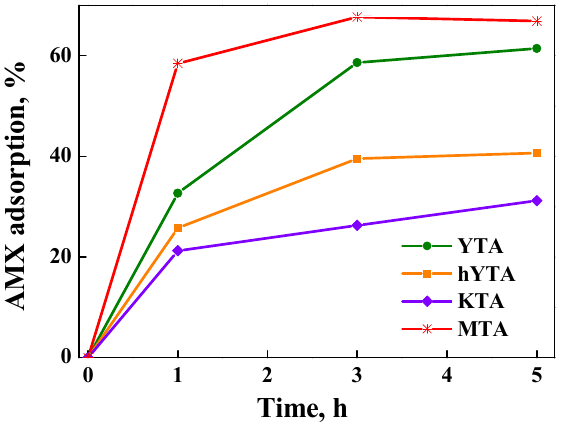
Figure 8. Adsorption capacity of photocalysts in amoxicillin degradation.